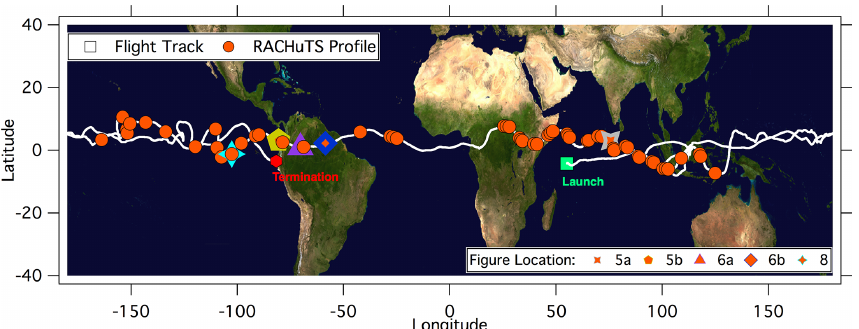
Figure 4. Flight trajectory of the TTL3 balloon during the Stratéole 2 engineering test. The trajectory represents 101d of flight, each point is the position of a 2km RACHuTS profile. Locations of the profiles in Figs. 5, 6, and 8 are marked. Base map courtesy of NASA Visible